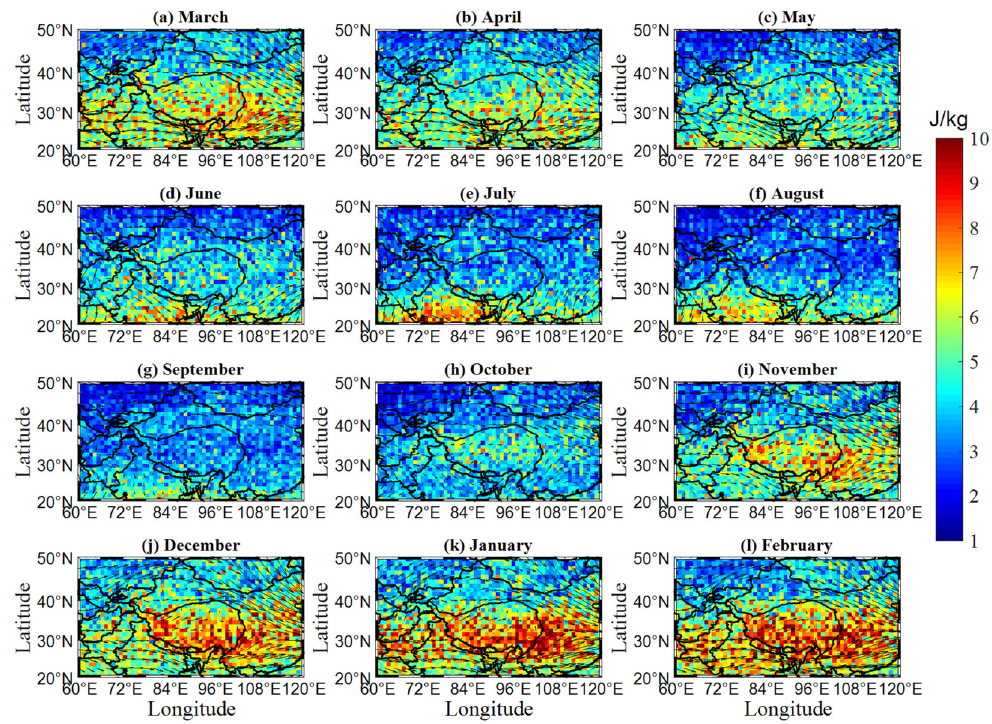
Figure 7. The spatial distribution of monthly mean GW Ep of 18~20 km around TP (20~50°N, 60~120°E) from August 2006 to September 2020. Region of TP: Latitude, 25~41°N; longitude: 68~105°E. The arrow represents the background wind.